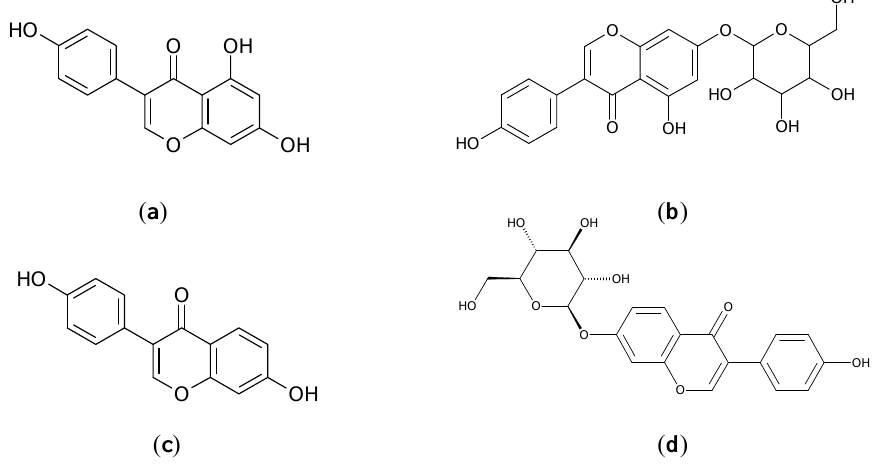
Figure 4. Bioactive phytochemicals of glucine max L. include the isoflavones